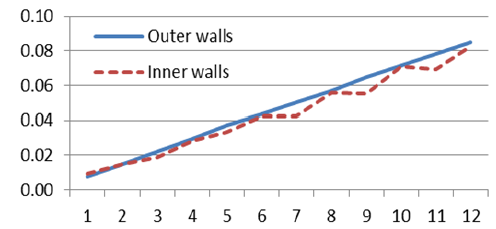
Figure 4. Angle precision in degrees as a function of the number of passed corners in the corridor.